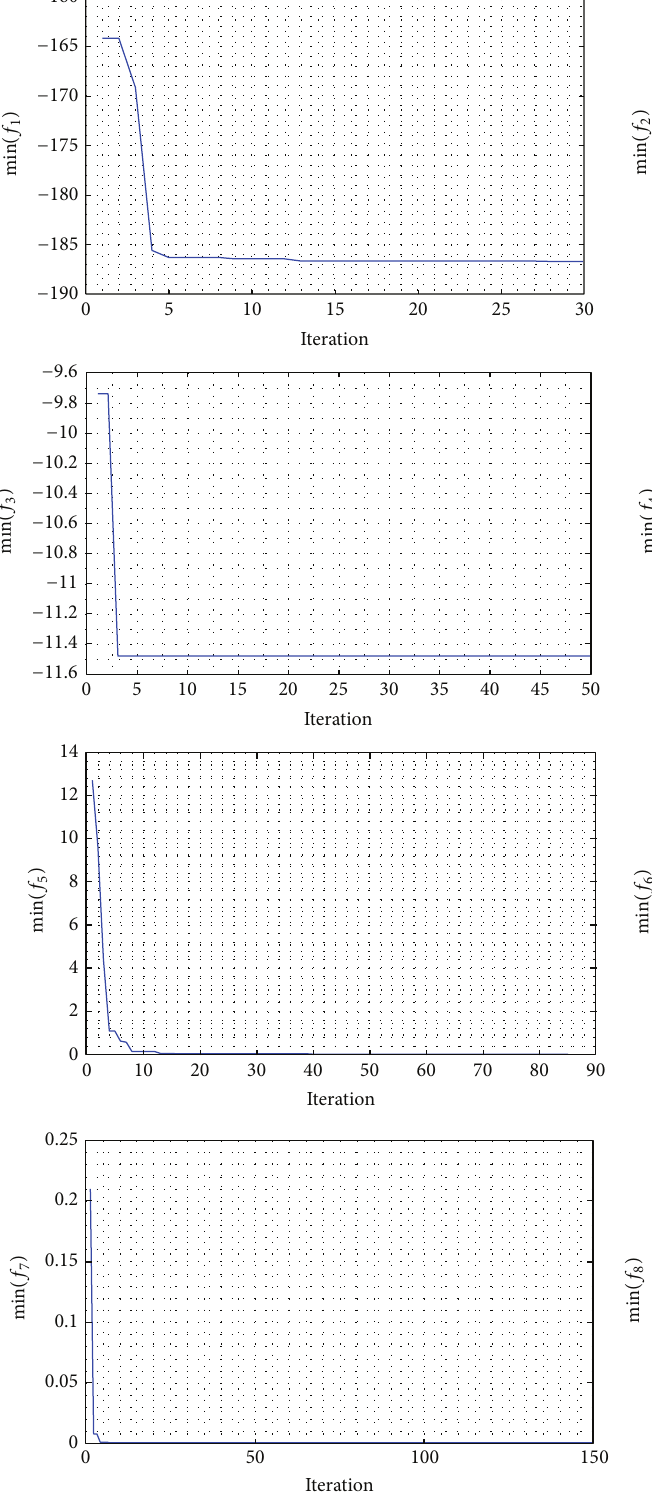
Figure 6: Performance of 𝑛𝑚 -PPA with the iteration on the selected eight benchmark